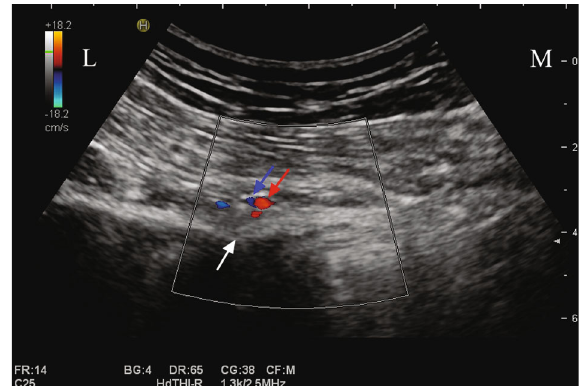
Figure 2: Internal pudendal artery presented in color Doppler. White arrow: ischium spine; red arrow: internal pudendal artery; blue arrow: internal pudendal vein. L: lateral; M: